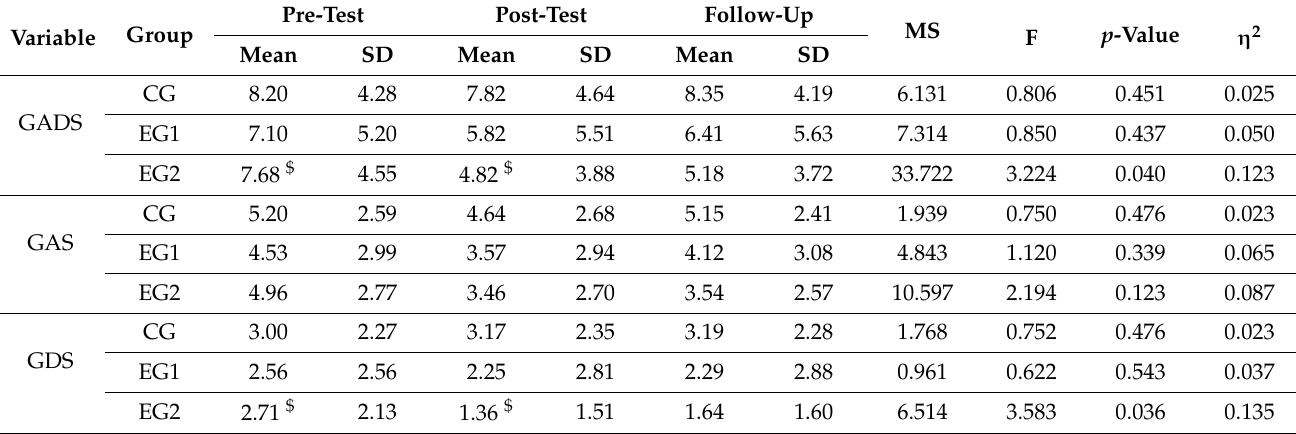
Table 3. Intra-group comparison of GADS, GAS, and GDS at the same evaluation moment. ANOVA for repeated measures. Pre-Test Post-Test Variable Group